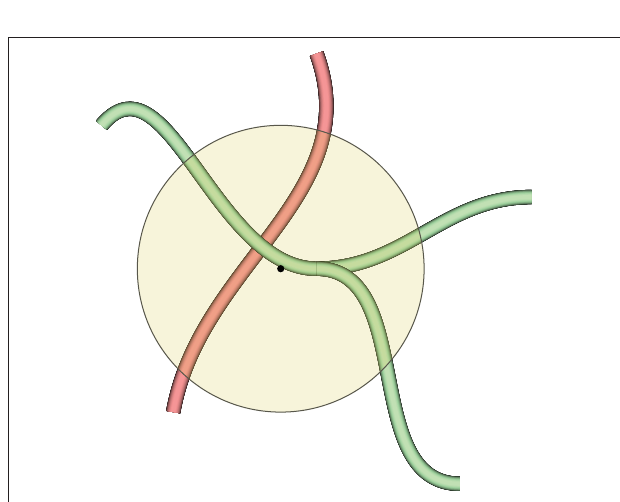
would like to mark the green blood vessels inside the circle, but do not want to co-mark the red blood vessel, even if it is also inside the circle. Red and